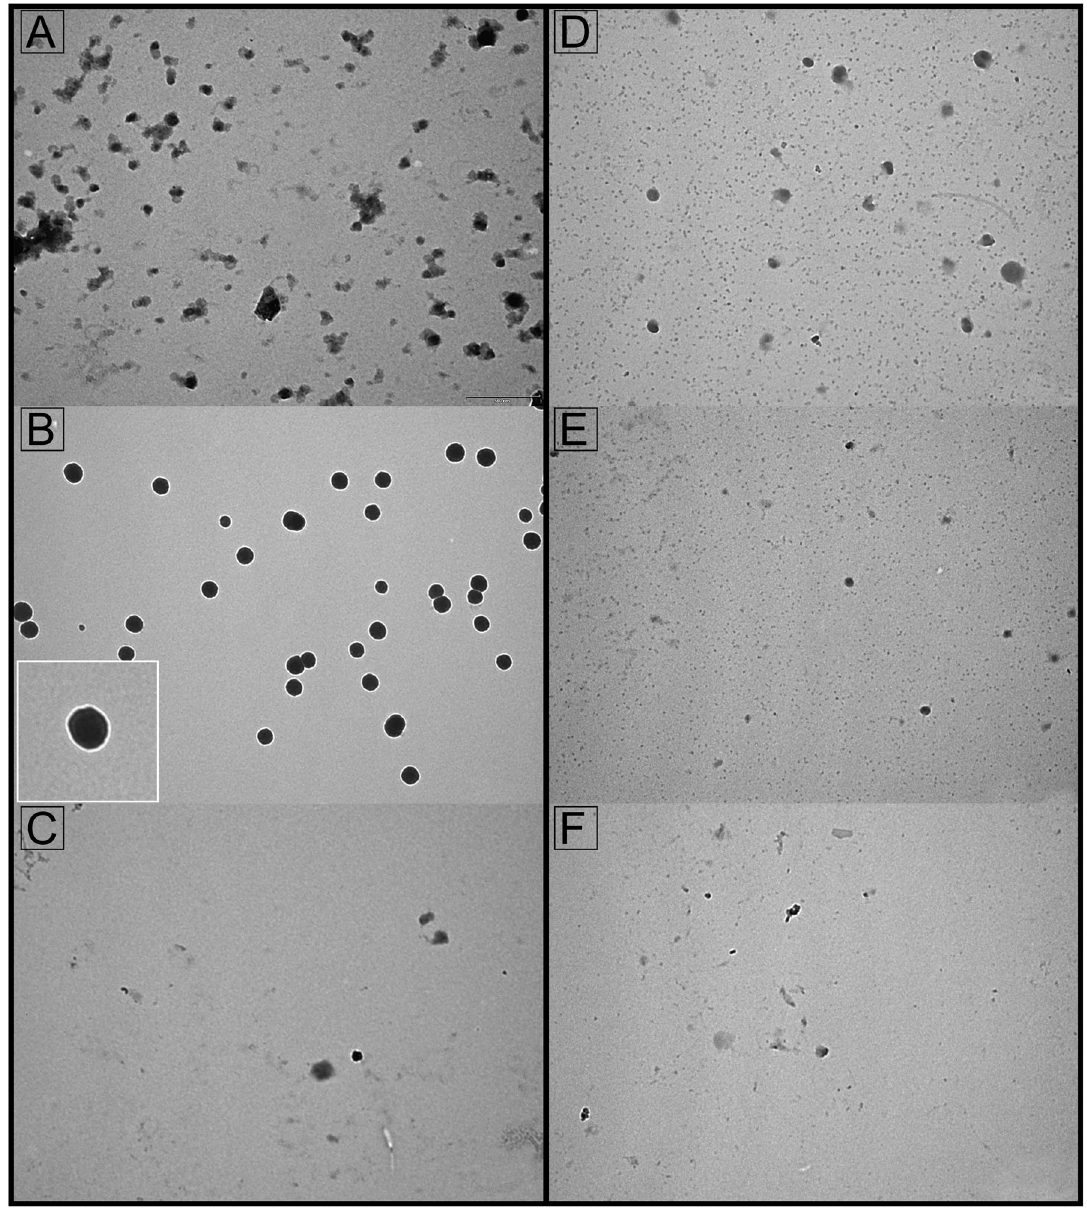
Figure 4. Transmission electron microscopy of seminal prostasomes from oligozoospermic men separated by lectin-affinity chromatography. Micrographs of vesicles (70 – 120nm) in a concanavalin A (Con A)-non-bound fraction (A) and vesicles (80 – 170nm) in a Con A-bound fraction (B). The insert shows the typical cup- shape appearance enlarged. Micrographs of vesicles (70 – 130nm) in a wheat germ agglutinin (WGA)-non-bound fraction (D) and vesicles (50 – 100nm) in a WGA- bound fraction (E). Vesicles in the high-pH-eluted fraction from Con A column (C) and low-pH-eluted fraction from WGA column (F) were